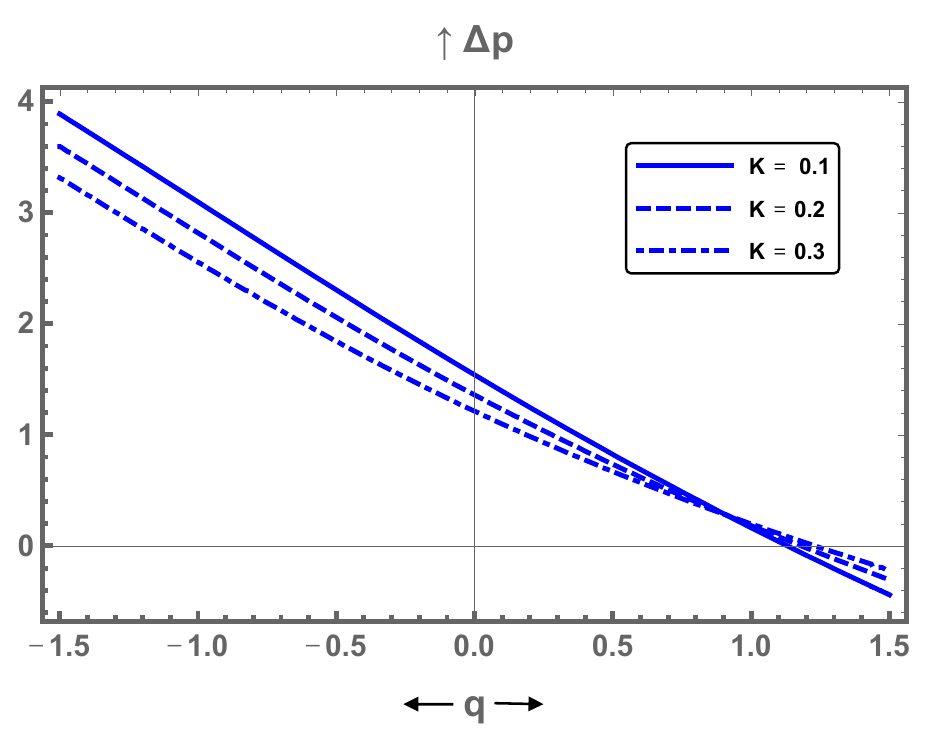
Figure 23. Display of pressure rise vs. volume flow rate for different values of K .